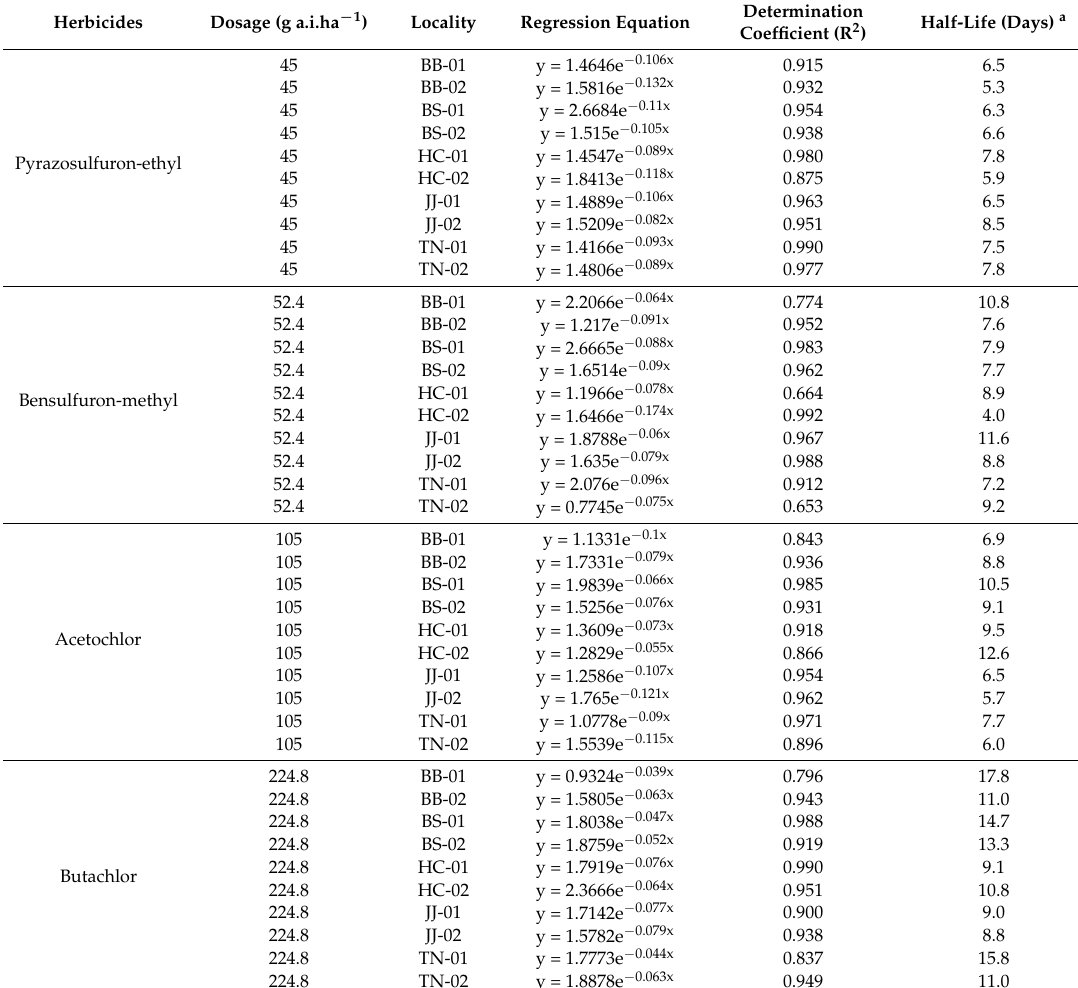
Table 6. The dissipation half-lives of the four herbicides in rice soil (high-dosage). Herbicides Dosage (g a.i.ha − 1 ) Locality Regression Equation